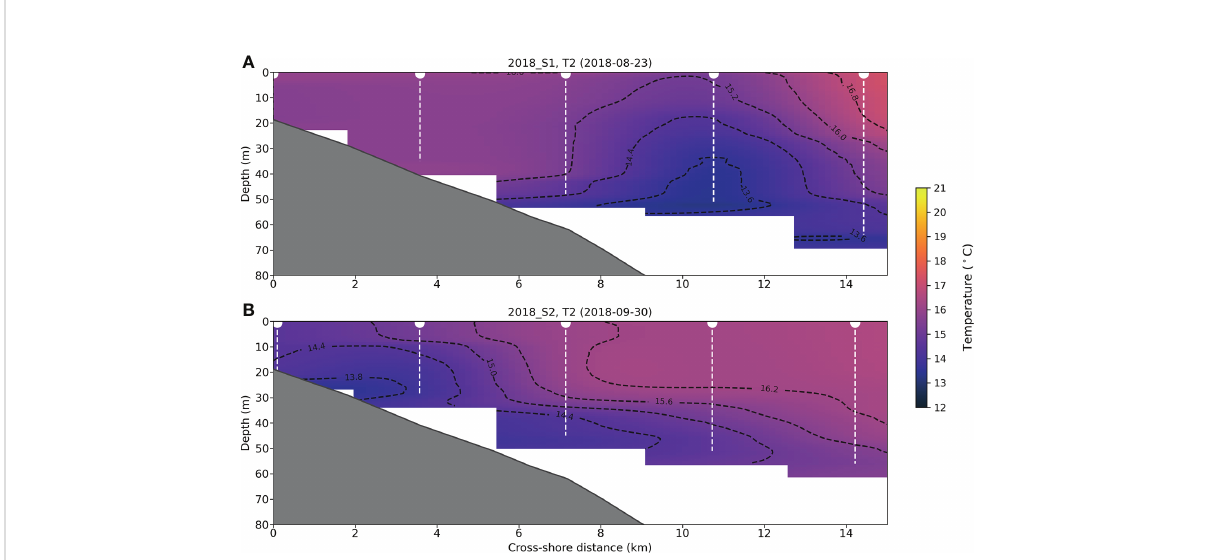
FIGURE 9 Comparisons of interpolated CTD cross sections of transect 2 showing water temperature (colour), the CTD pro fi le depths (white dotted lines) and the sea fl oor as determined from acoustic sampling (grey area) for (A) survey 2018 S1 and (B) 2018 S2. Interpolation of temperature from CTD casts was performed using radial basis function